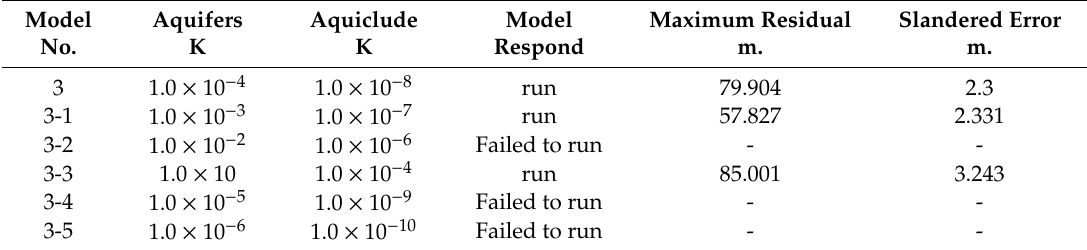
Figure 8. Results for manual calibration and sensitivity. Table 3. Results for implemented model three and K× values.